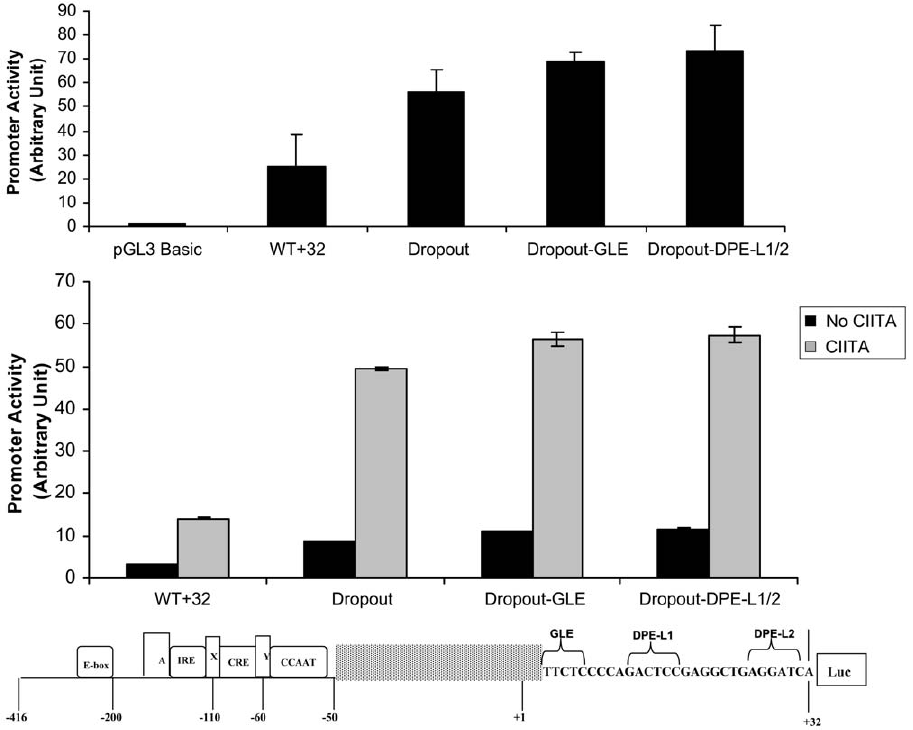
Figure 6. Downstream elements preferentially regulate transcription initiating in the upstream promoter region. HeLa cells were transfected with the wild type dropout construct (5 ug), which has a deletion in the region between 2 50 and + 3 in the context of 2 416/ + 32 construct ligated to the luciferase (luc) reporter (see schematic at bottom on Figure), and derivative downstream elements mutant constructs with mutations at GLE and DPE-L1/2 (top). HeLa cells were also co-transfected with a CIITA-expression vector (or a control vector) and the dropout construct or its derivative downstream element mutants (bottom). The amount of luciferase activities was determined as described in Materials and Methods.